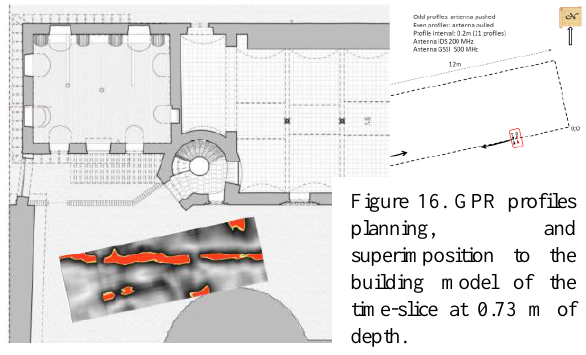
Figure 16. GPR profiles planning, and superimposition to the building model of the time-slice at 0.73 m of